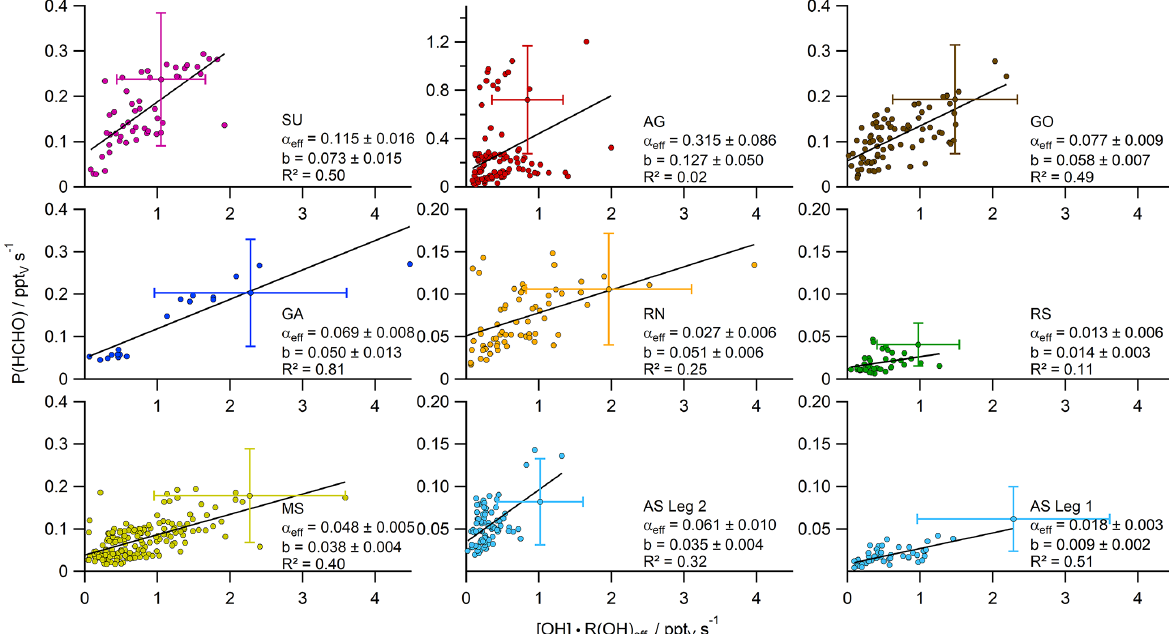
Figure 4. Scatter plots with bivariate fits (York et al., 2004) of the product [ OH ]× R ( OH ) eff ( ± 58%) versus the HCHO production rate P ( HCHO ) ( ± 62%), subdivided into the different regions probed during the AQABA cruise. The slope of the respective regression represents the HCHO yield α eff , while the intercept can be interpreted as additional HCHO sources not related to OH chemistry (P add ( HCHO )